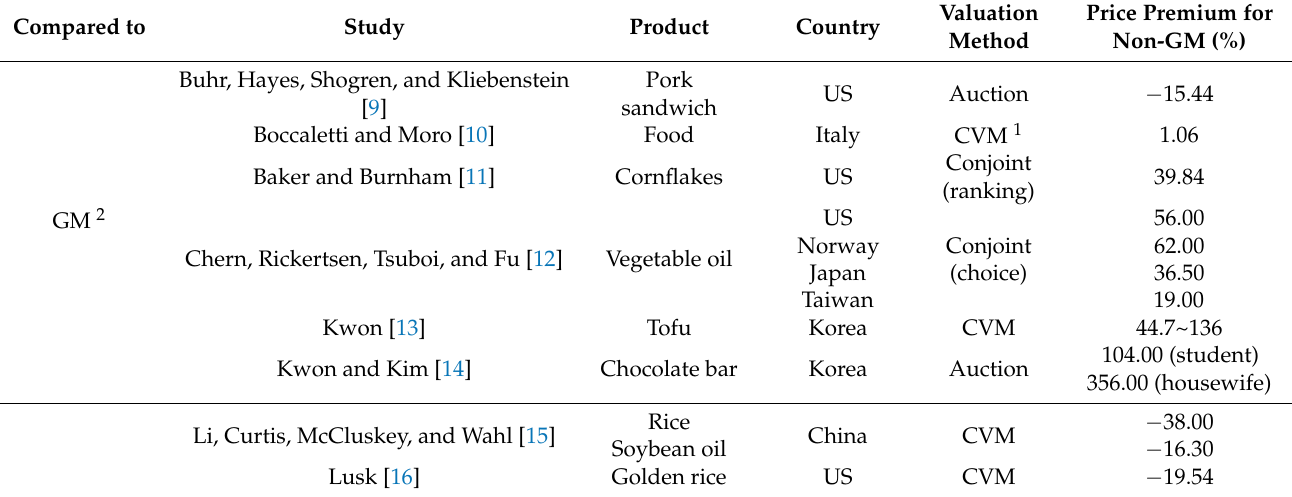
Table 1. Summary of the previous studies on the consumer evaluation of GM and GE foods. Compared